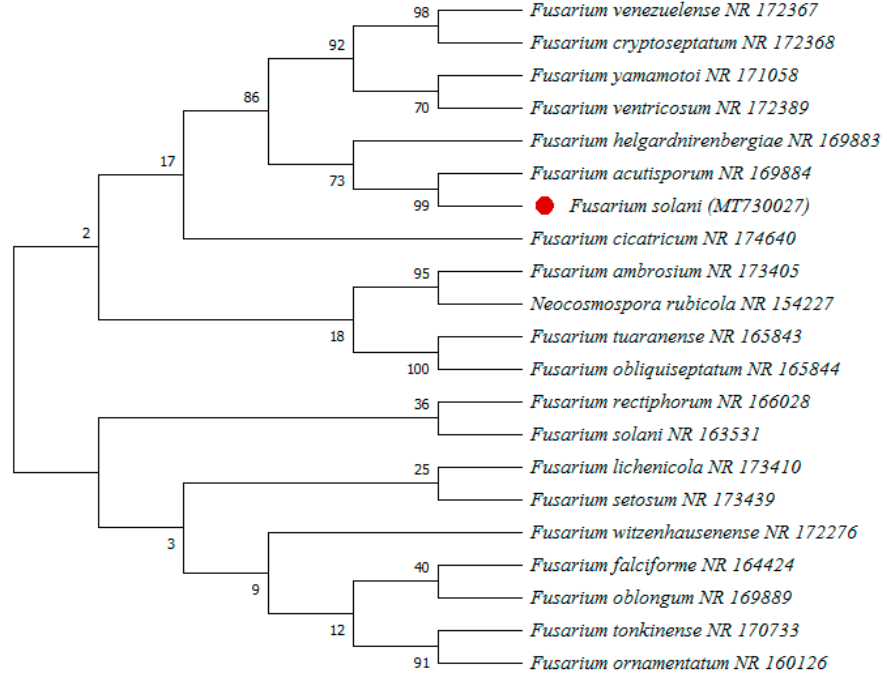
Figure 2. Semistrict concurrence of most parsimonious identified isolate No. 7 ( Fusarium solani ) based on sequenced data. This tree was overall compatible with highly supported lineages according to the Bayesian 50% majority-rule consensus tree. Jackknife frequencies (10,000 replicates) are shown above each node. The red dot in the figure represents isolate 7, identified as Fusarium solani .